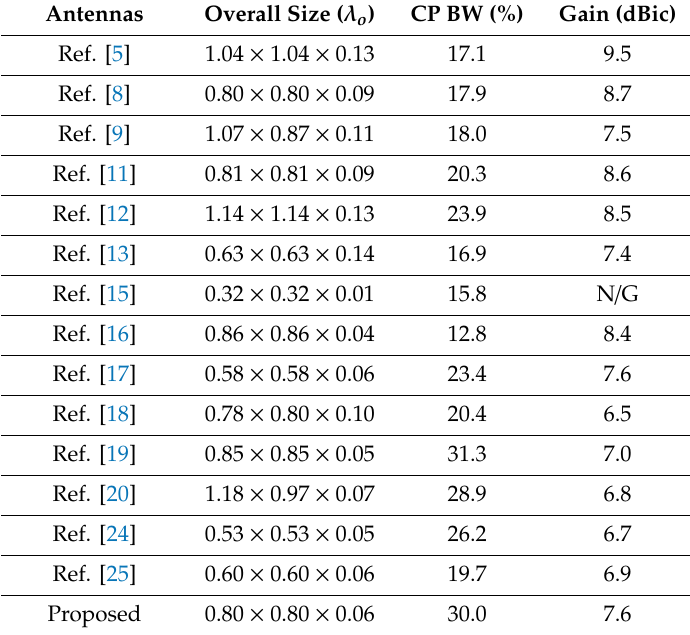
Table 1. Performance comparison among the low-profile, single-fed, wideband CP antennas. BW: bandwidth.